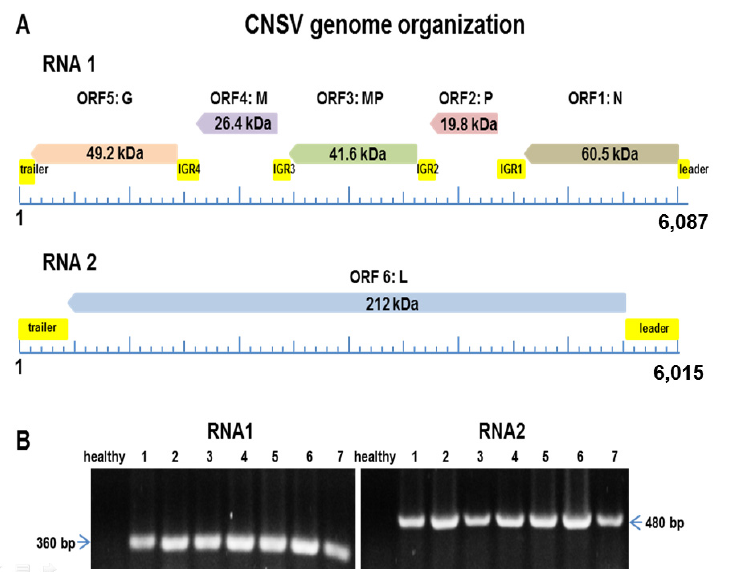
Figure 2. Map of Citrus Necrotic Spot Virus (CNSV) genome components and putative open reading frames in both RNA1 and two components. ( A ) Leader and trailer RNAs and intergenic regions (IGR) are also depicted. N, nucleocapsid protein; P, phosphoprotein; MP, movement protein; M, matrix protein; G, glycoprotein; L, RNA-dependent RNA polymerase. ( B ) RT-PCR from representative C. × aurantium leaf samples showing leprosis symptoms. ( Left ) The lane marked as “healthy” is non-symptomatic tissue and Lane 1 to 7: independent samples. The left panel is the detection of the RNA1 component. ( Right ) The detection of